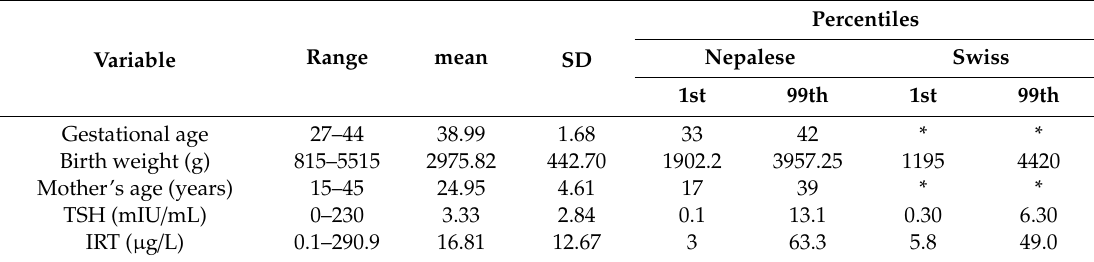
Figure 1. The distribution curves of all analytes from 4360 sample values. TSH—thyroid stimulating hormone, IRT—immunoreactive trypsinogen, OHP—17- α -hydroxy progesterone, tGal—total galactose, GALT—galactose-1-phosphate uridyl transferase, Phe—phenylalanine, Tyr—tyrosine, C8—octanoylcarnitine, C5DC—glutarylcarnitine, Leu / Ile—leucine / isoleucine, Val—valine. Units of measurement are as in Table 1. Table 1. Measured parameters in the Nepalese population in comparison with the 1st and 99th percentiles in the Swiss population.